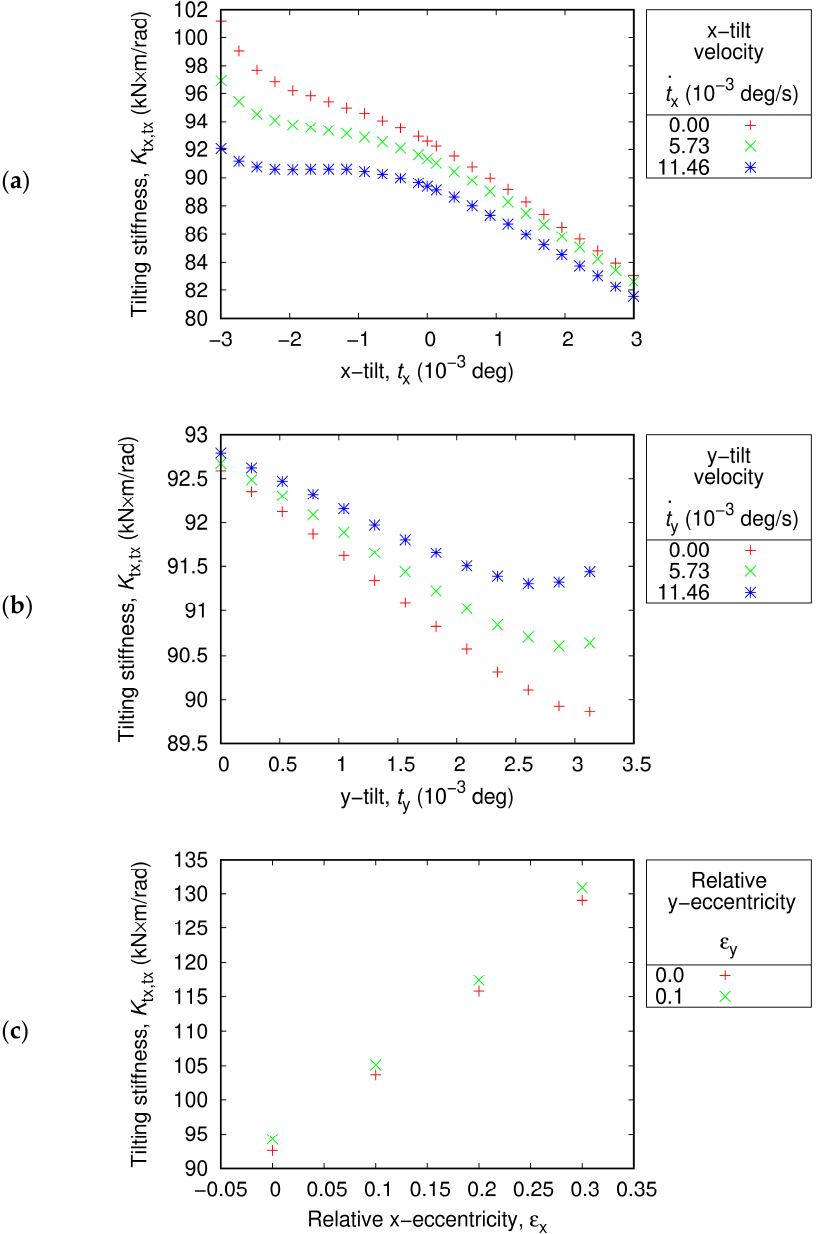
Figure 4. Parameter sensitivity of the direct stiffness coefficient K tx , tx : ( a ) Effects of the tilting angle and tilting velocity in the x-direction; ( b ) Effects of the tilting angle and tilting velocity in the y-direction; ( c ) Effects of relative eccentricities. All unreferenced parameters have zero values.